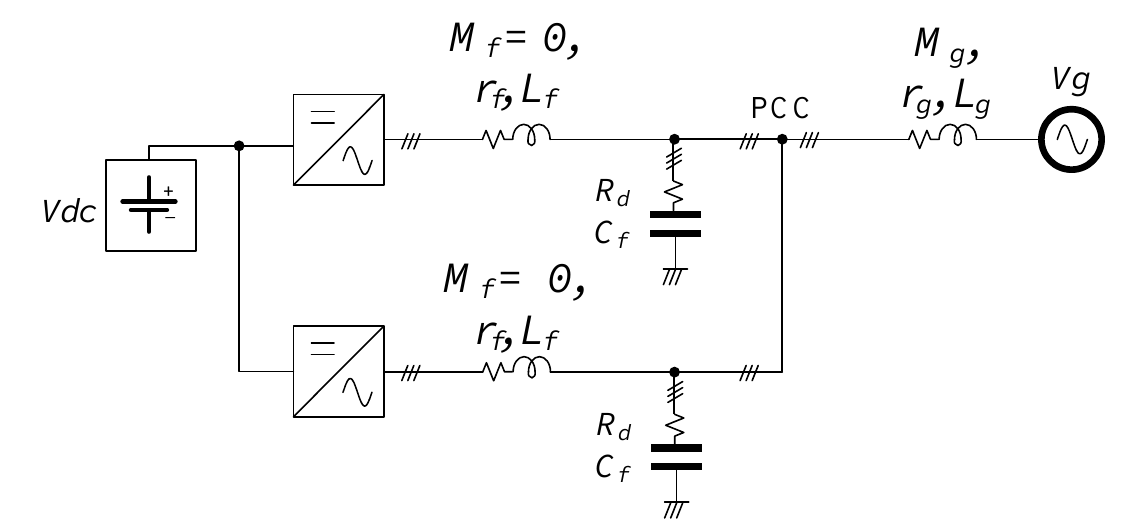
Figure 5. Single-line scheme of two inverters connected in parallel. Table 4. Parameters of the inverters.